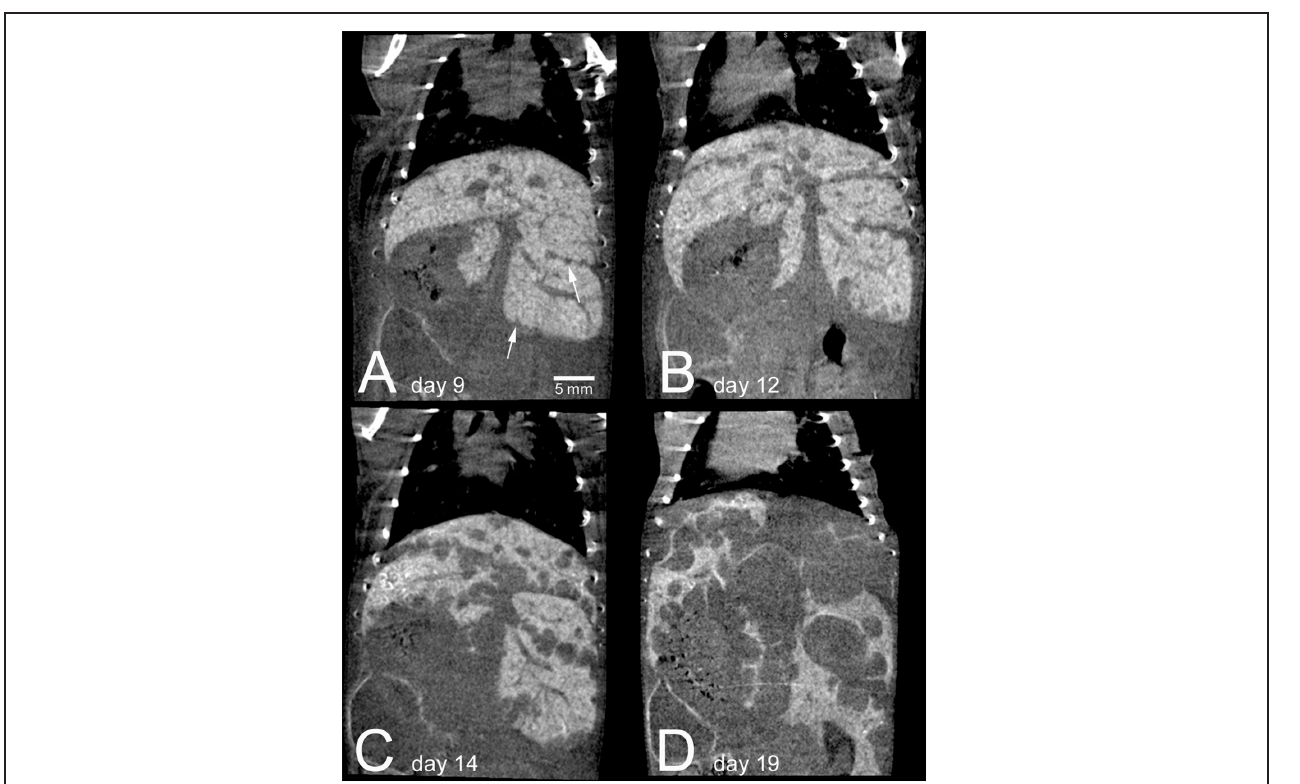
FIGURE 8 | Longitudinal micro-CT imaging of liver metastases in a mouse following injection of a nanoparticle contrast agent. A single mouse is shown at 9 days (A) , 12 days (B) , 14 days (C) , and 19 days (D) after intrasplenic injection of tumor cells. Normal liver tissue is highly enhancing due to nanoparticle uptake, while the tumor regions show no enhancement. The enhancement remains high within the normal liver over the entire course of the experiment. By day 19, metastatic tumors take up the majority of the liver volume. Reprinted from (Boll et al., 2011) under the Creative Commons Attribution License.